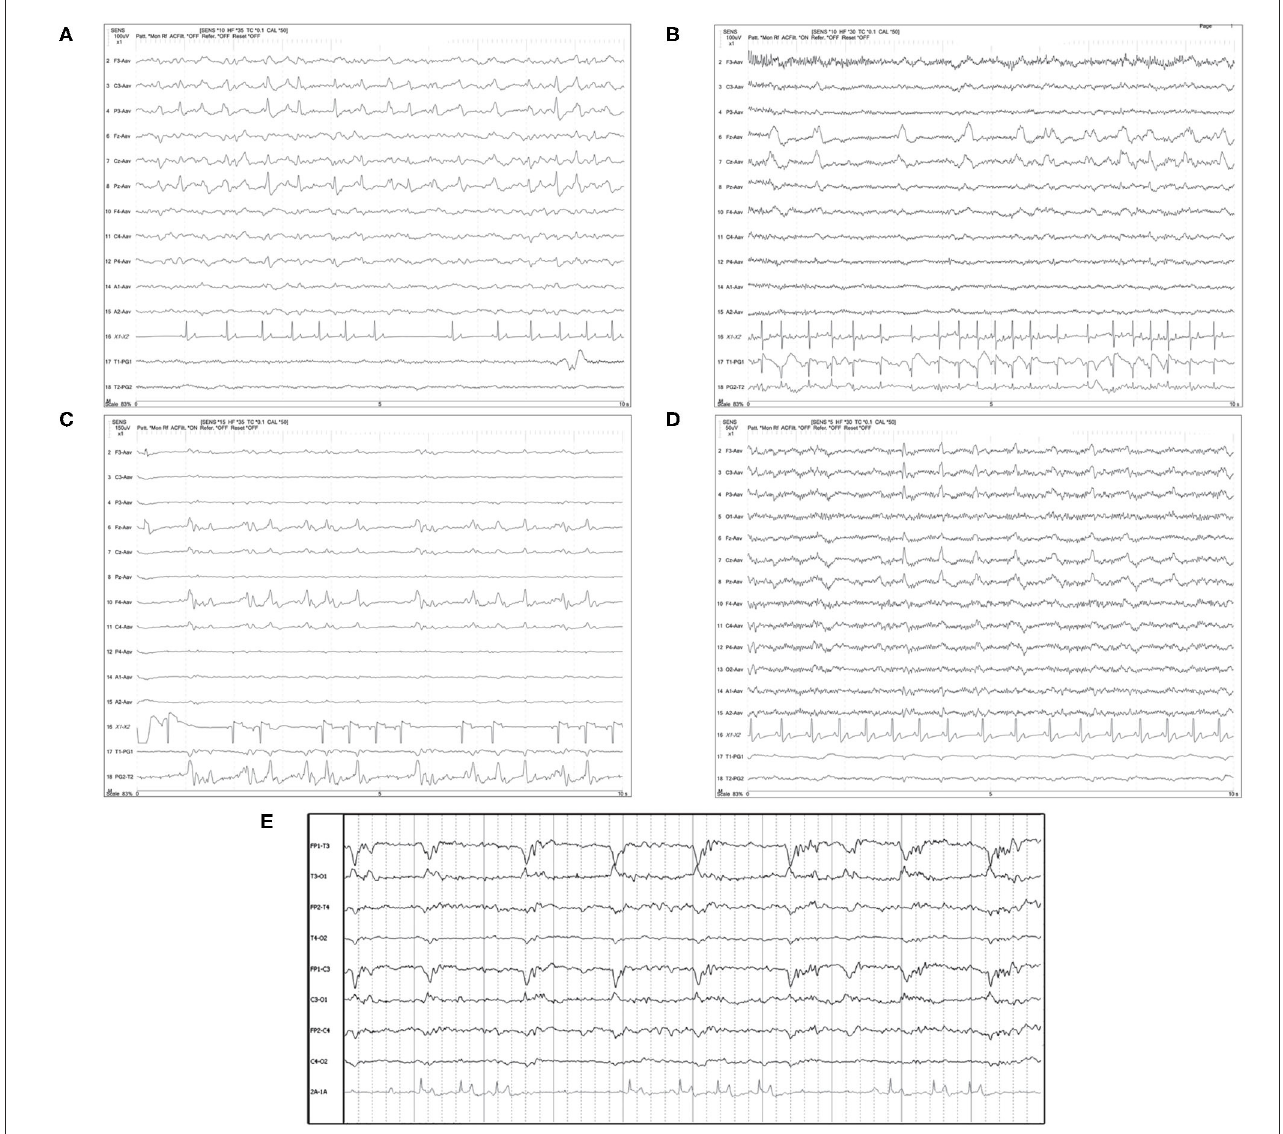
FIGURE2 Referential (A–D) and bipolar (E) montages of five cases with lateralized periodic discharges (LPDs). (A) Left parietal LPDs in a 12 year old pug with cluster seizures, normal brain MRI (HF 35Hz, sensitivity 7 uV/mm). (B) Frontal midline LPDs in a 14 year old Chihuahua mix with cluster seizures secondary to hypoglycemia and an insulin-secreting tumor (HF 30Hz, sensitivity 10 uV/mm). (C) Right frontal LPDs in an 11 year old miniature Pinscher with recent SE and history of transfrontal craniotomy 6 months previously for right olfactory/frontal lobe meningioma (HF 35Hz, sensitivity 15 uV/mm). (D) Left hemisphere LPDs in an 11 year old Labrador with recent cluster seizures and history of craniotomy 6 months previously for left occipital meningioma (HF 30Hz, sensitivity 5 uV/mm). (E) Left hemisphere polyphasic LPDs (phase reversal at T3 and C3) in an 8 year old soft-coated Wheaton terrier with metastatic neoplasia (HF 35Hz, sensitivity 5